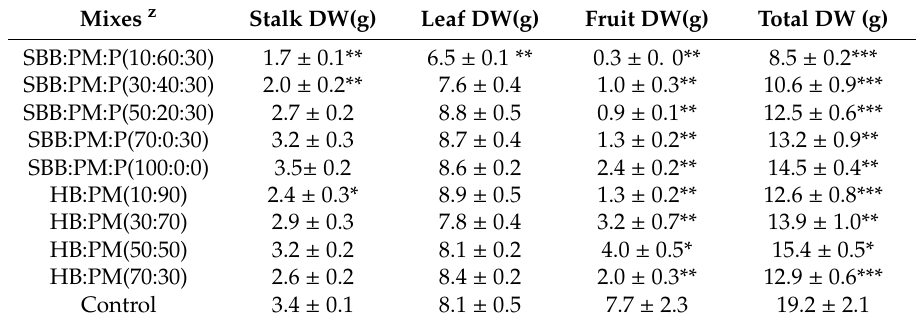
Figure 6. The growth index (a) and SPAD (b) of tomato seedlings from biochar-amended mixes after four weeks in commercial substrate. SBB = sugarcane bagasse biochar; HB = mixed hardwood biochar; CS1 = commercial growing substrate. SBB (10%, 30%, 50%, 70% and 100%; by vol.) incorporated with 30% perlite with the rest being peat moss; HB (10%, 30%, 50% and 70%; by vol.) incorporated with peat moss. (*, ** indicate a significant difference from the control using Dunnett’s test at P ≤ 0.05 and P ≤ 0.01, respectively) Table 4. Stalk, leaf, and fruit dry weight (g) of tomato seedlings from biochar-amended mixes after four weeks in the commercial substrate. (*, ** indicate a significant difference from the control using Dunnett’s test at P ≤ 0.05 and P ≤ 0.01, respectively)